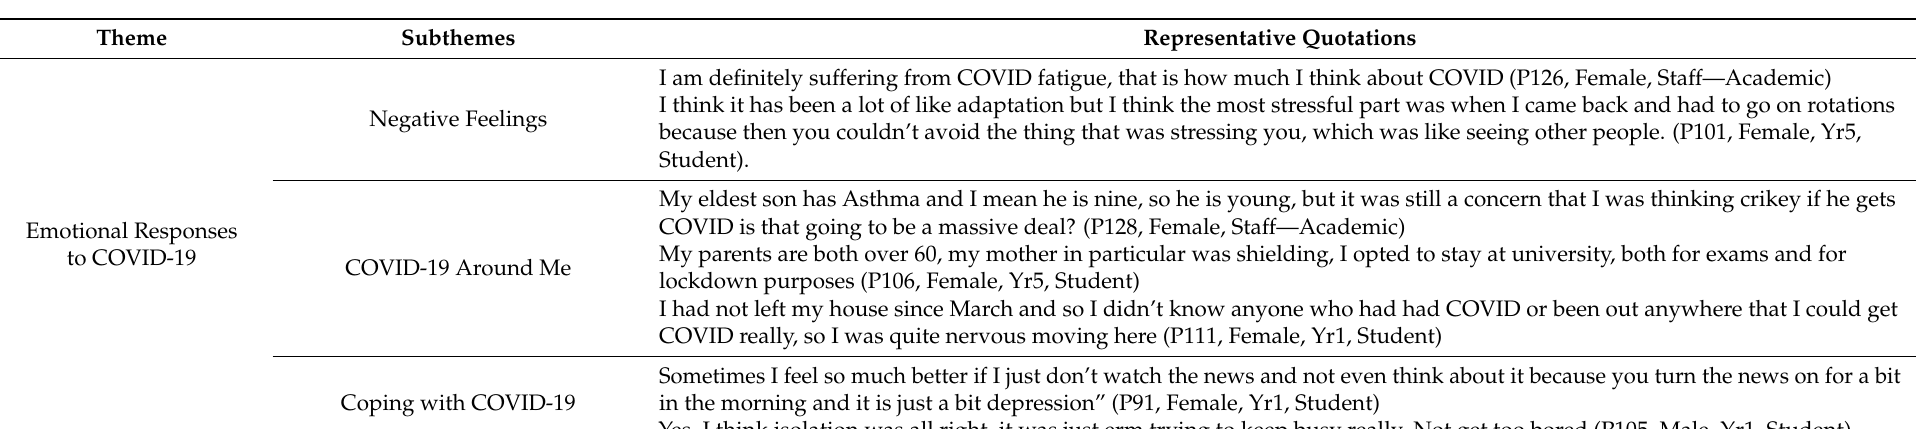
Table 12. Key themes and subthemes and their representative